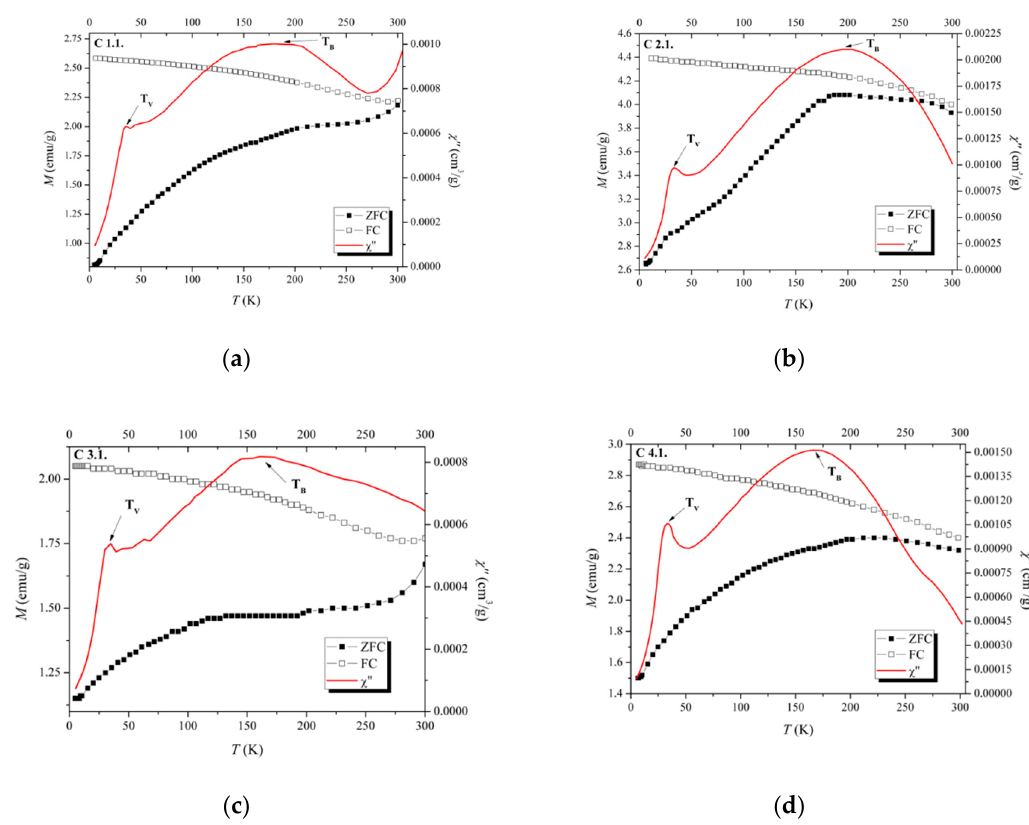
Figure 8. Temperature dependence of magnetization (ZFC / FC curves at 25 G) and AC susceptibility (out-of-phase component χ ” at 995 Hz) of coated SPIONs: ( a ) C 1.1, ( b ) C 2.1, ( c ) C 3.1, ( d ) 4.1.